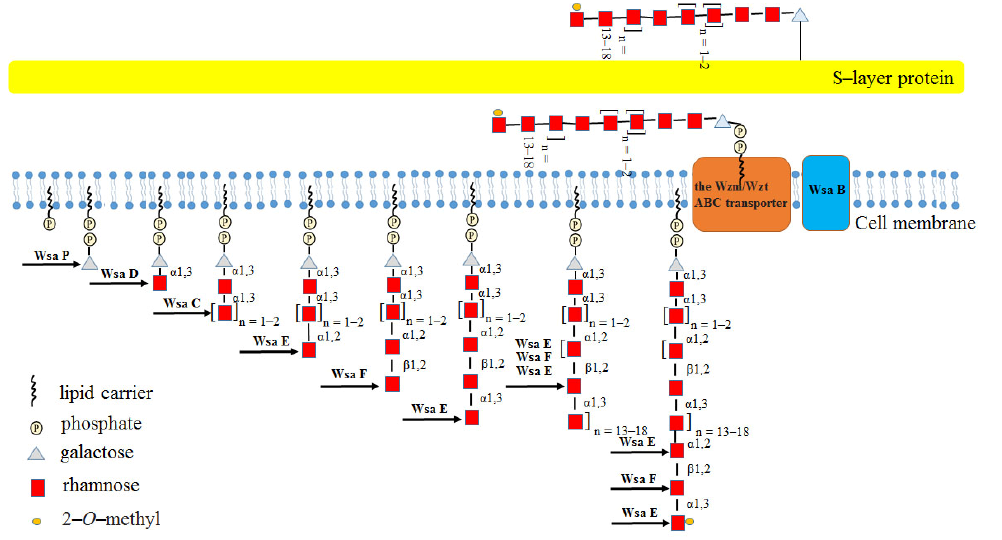
Figure 10. Diagram of the biosynthesis pathway of the S-layer glycoprotein glycan of Geobacillus stearothermoph ilus NRS 2004/3a.